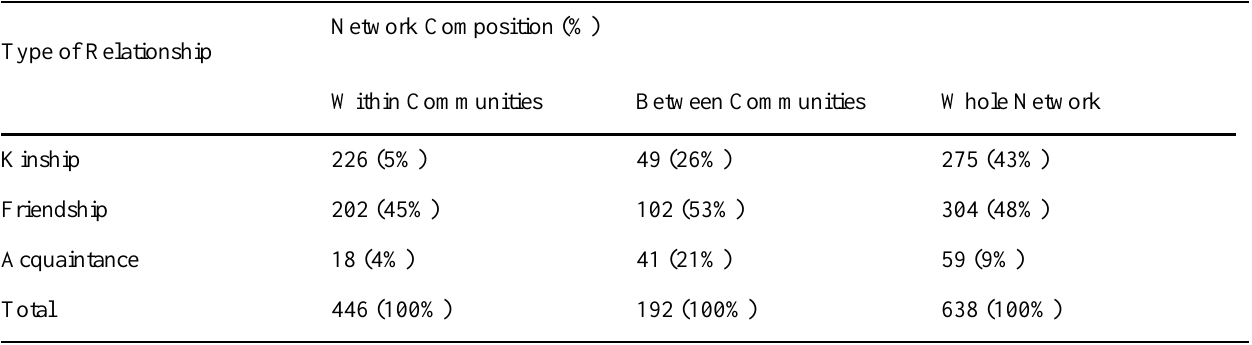
Table 2. Composition of the fishers’ network within and between communities and of the whole network. Type of